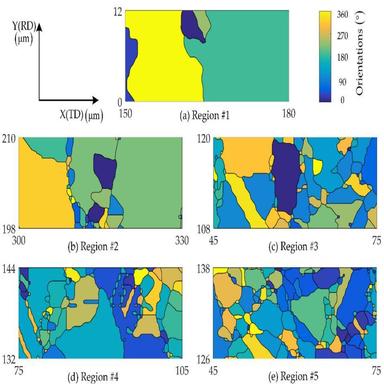
Selected regions for EBSD copying modeling.